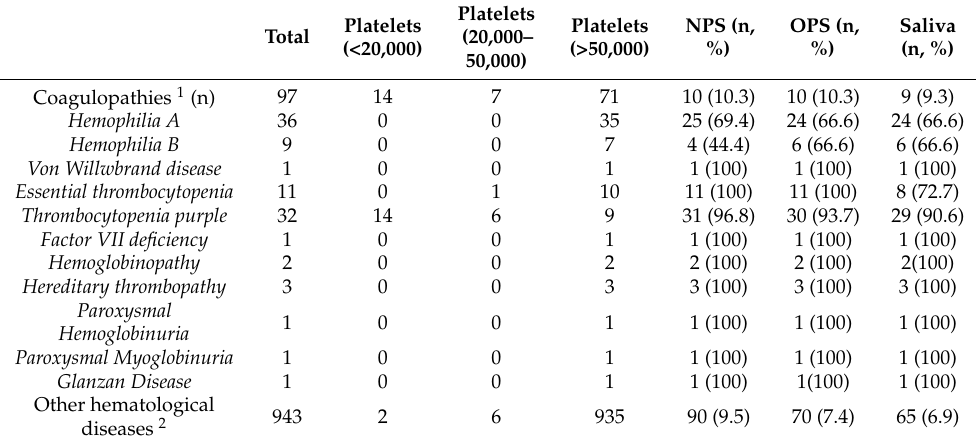
Table 2. Patients with coagulopathies and other hematological diseases.